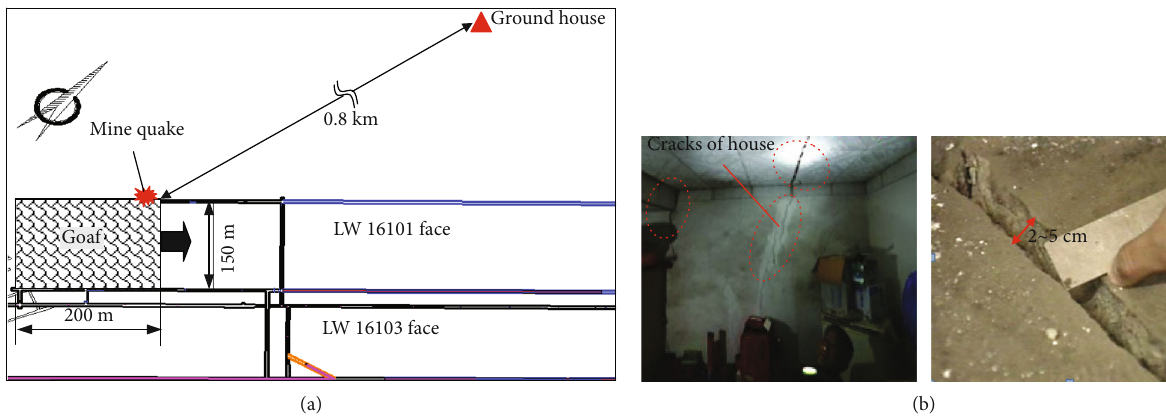
Figure 1: Engineering example of ground vibration damage of the mine quake. (a) Ground impact plan of the mine quake; (b) Images of damaged civilian building and ground after the mine